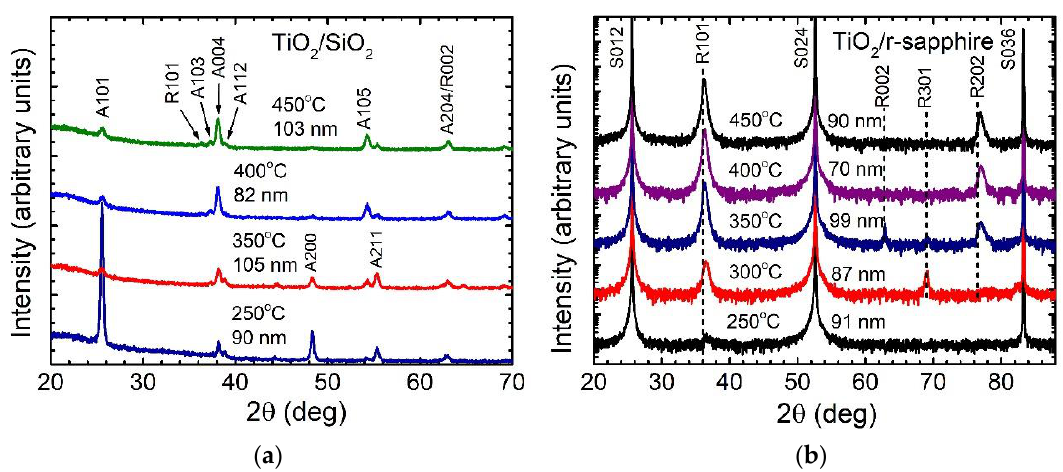
Figure 2. ( a ) GIXRD and ( b ) HRXRD patterns of TiO 2 films grown on ( a ) SiO 2 and ( b ) r-sapphire. Growth temperatures, film thicknesses, and Miller indices of anatase (A), rutile (R), and sapphire (S) are shown at diffraction patterns. ( b ) Vertical lines mark the database (PDF 78-2485) positions of rutile reflections.